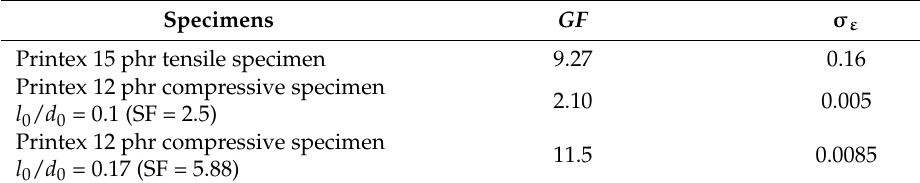
Table 6. Gauge factor and standard deviation of linear models adopted.